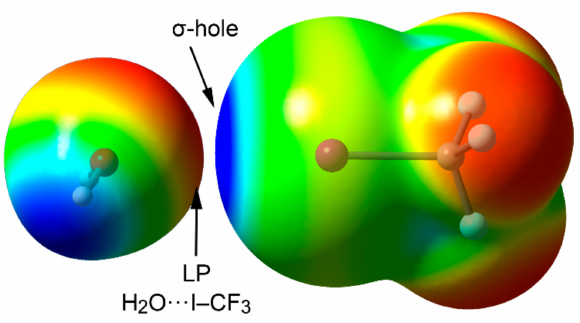
Figure 1. Graphical representation of a prototypical σ –hole complex between H 2 O and ICF 3 molecules as electron donor and acceptor moieties, respectively. Electropositive regions are repre- sented in blue and electronegative in